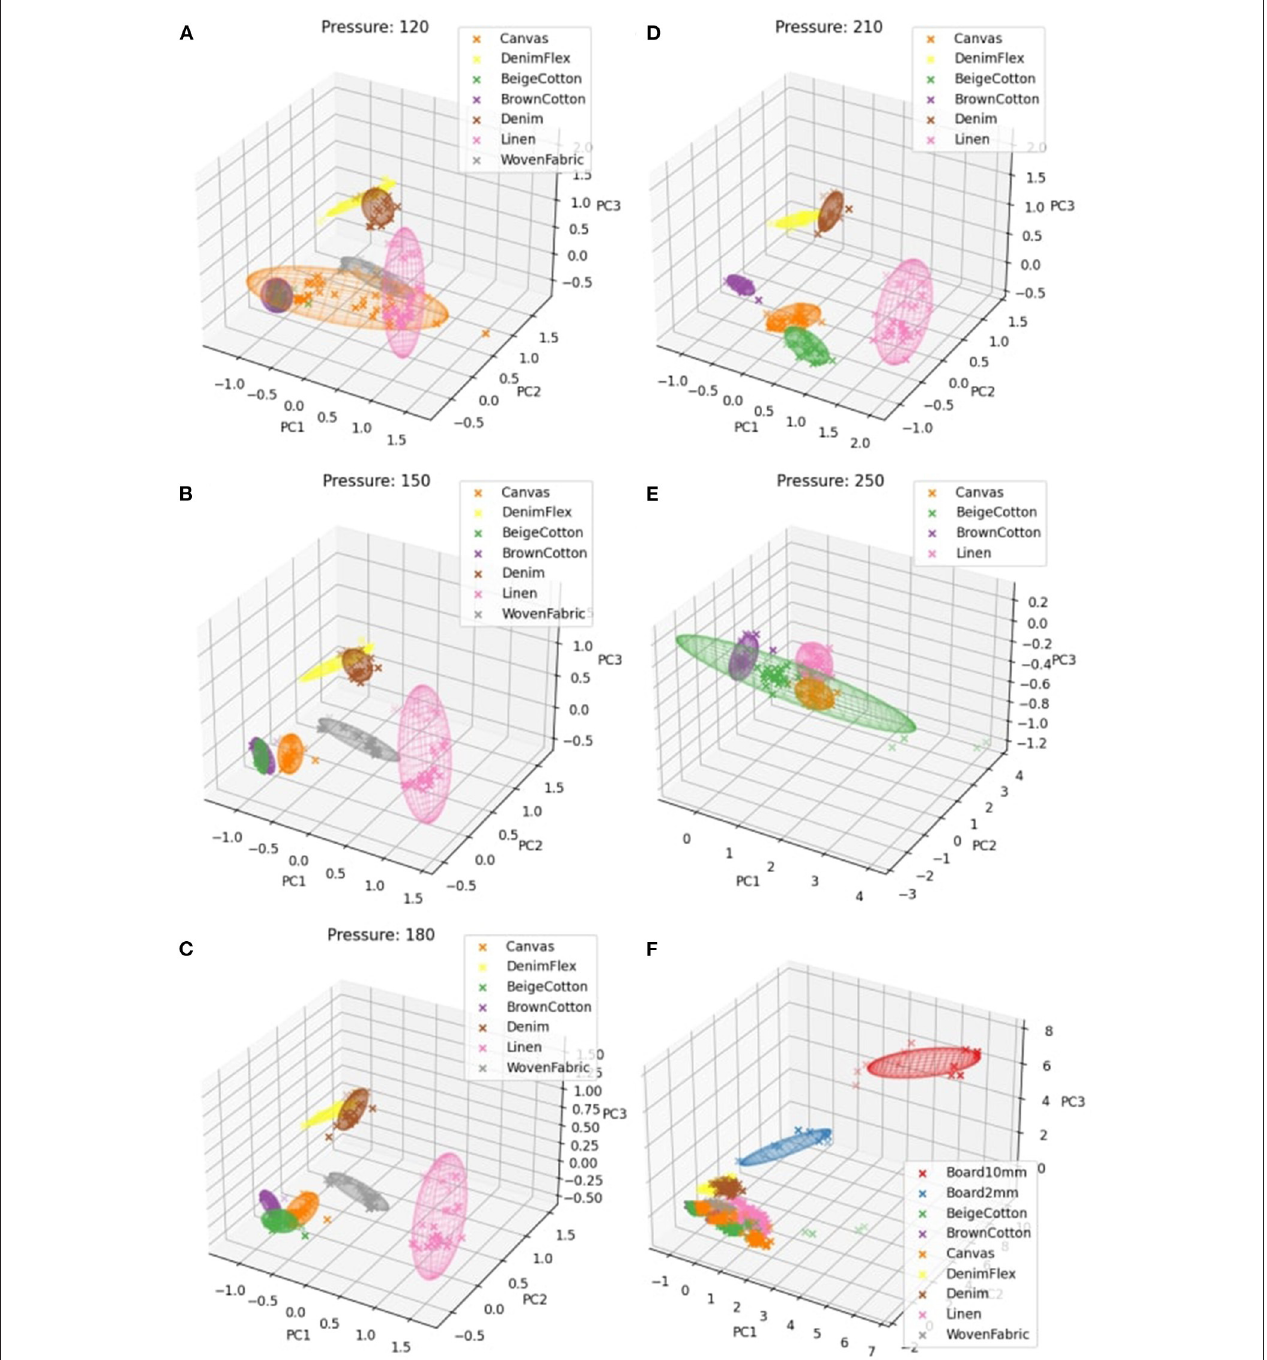
FIGURE 10 | Feature spaces (A–E) correspond to sliding pressure settings of 120, 150, 180, 210, and 250 of only fabrics. (F) is the feature space of all fabrics and polylactic acid (PLA) boards with all different speed and pressure settings. The 95% confidence ellipsoids are shown to illustrate the intra-class